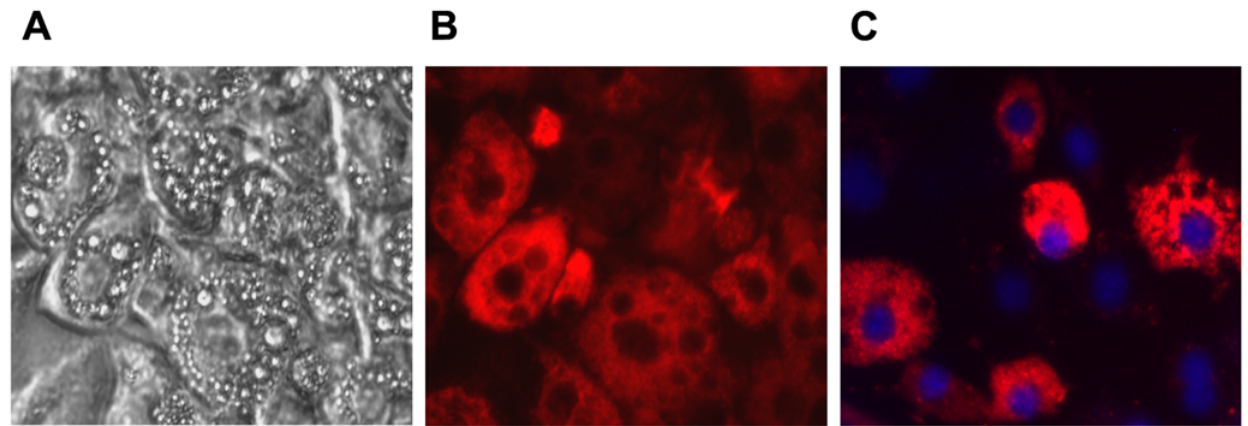
Figure 3. Adipocytes in suspension are efficiently transfected with siRNA. Uptake of the fluorescent-labeled siRNA was assayed at 48 hours post transfection of adipocytes plated at 1.16 6 10 5 cells/cm 2 . (A) Brightfield and (B) fluorescent (rhodamine filter) image of the transfected cells taken with a 40X objective. (C) Co-staining with DAPI and the fluorescent-labeled siRNA indicates the siRNA is located in the cytoplasm. The image in (C) is from a different experiment than the paired images in (A) and (B). This experiment was carried out independently greater than four times.